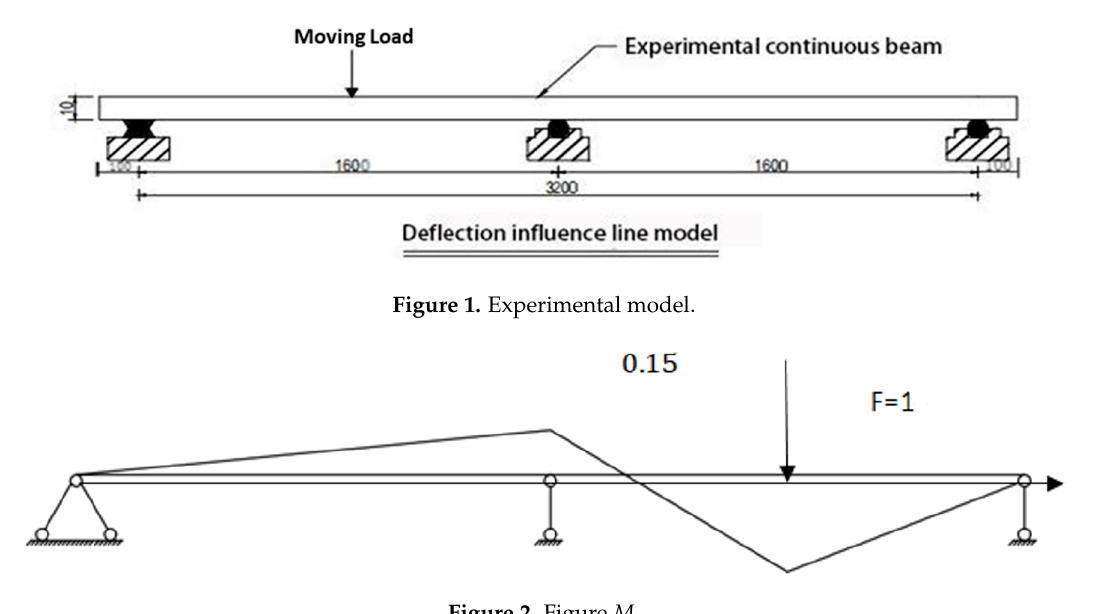
Figure 1. Experimental model.